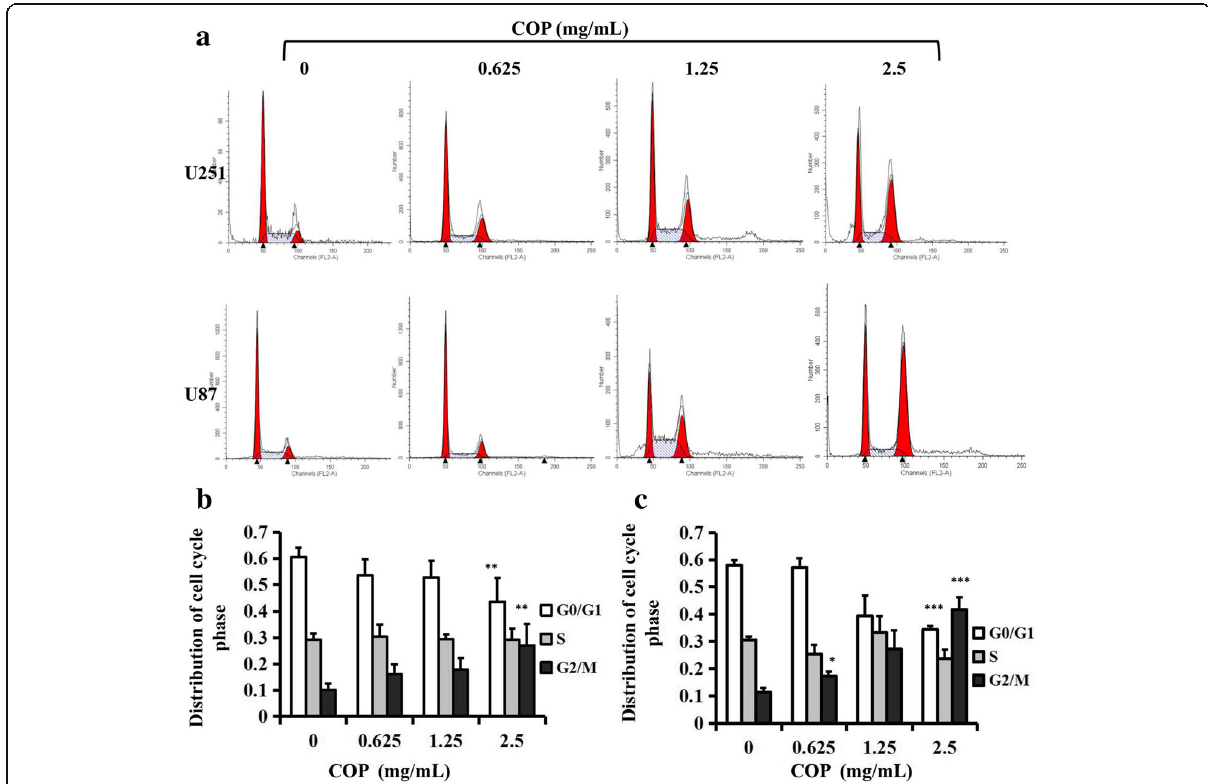
Fig. 6 COP induces G2/M phase arrest U251 and U87 cells. a Flow cytometry showed U251 and U87 cells were blocked at G2/M phase. b U251 was arrested in G2/M phase. c U87 was arrested in G2/M phase. *, P < 0.05; **, P < 0.01; ***, P < 0.001 compared with the control